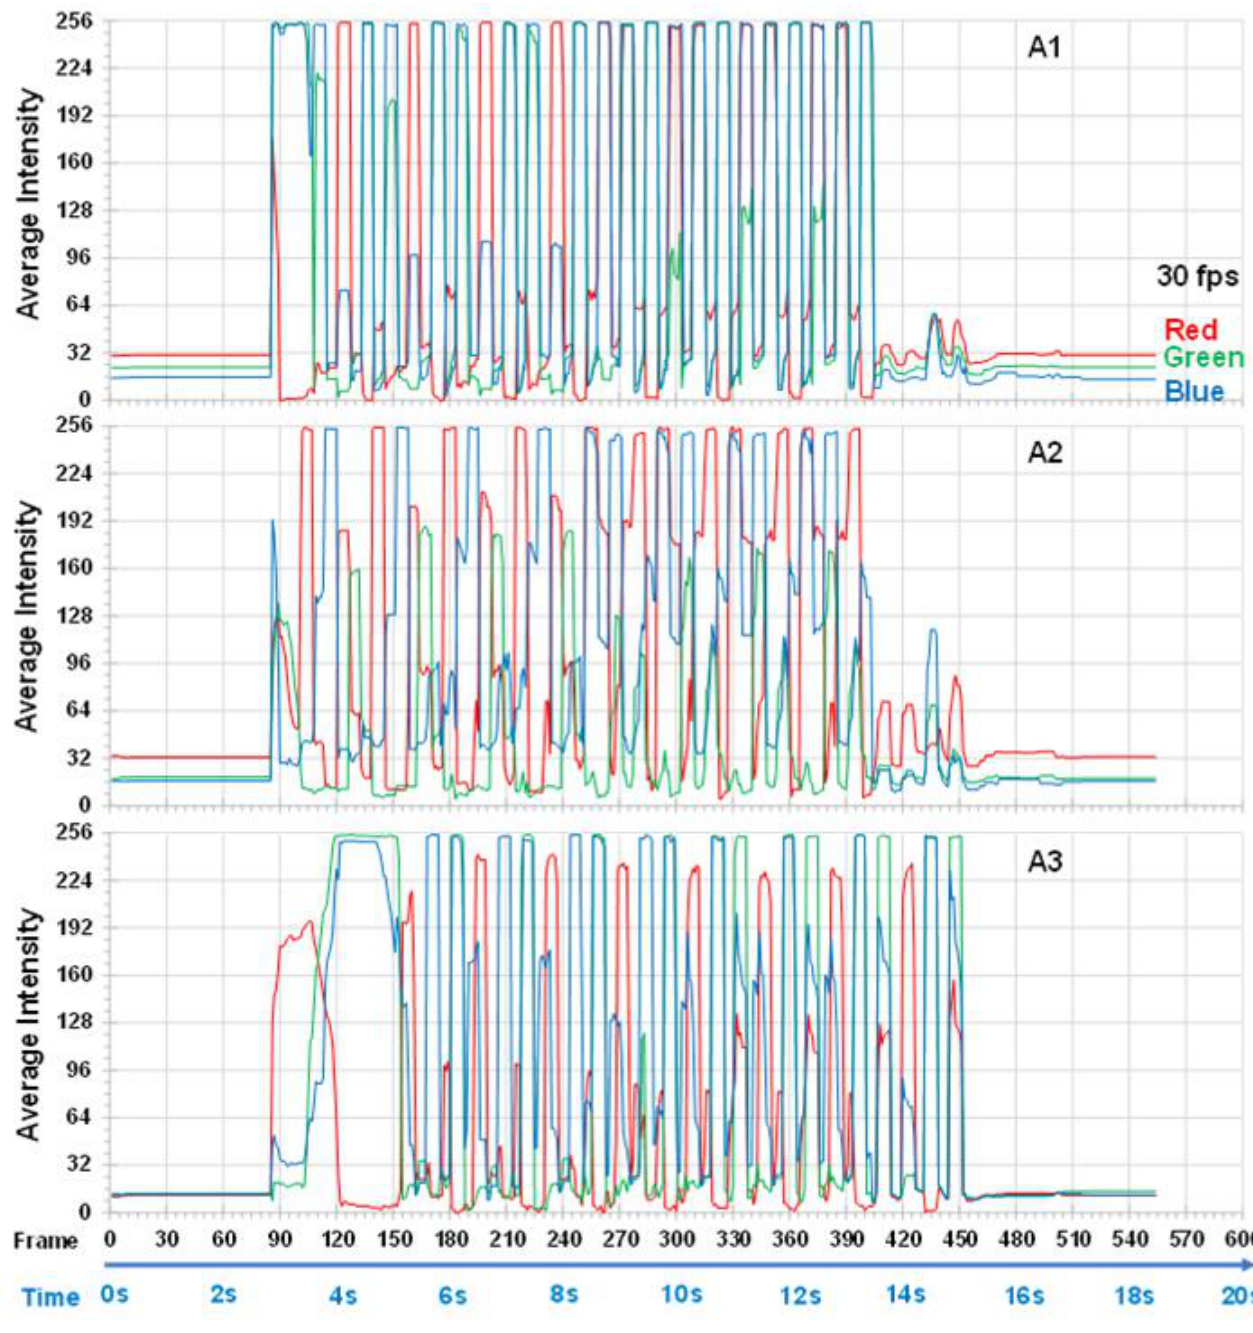
Figure 8. Decoded LED blinking sequence from analysis of a video clip using PicMan (average of 100 pixels (=10 pixel × 10 pixel) at square areas (A1, A2 and A3).